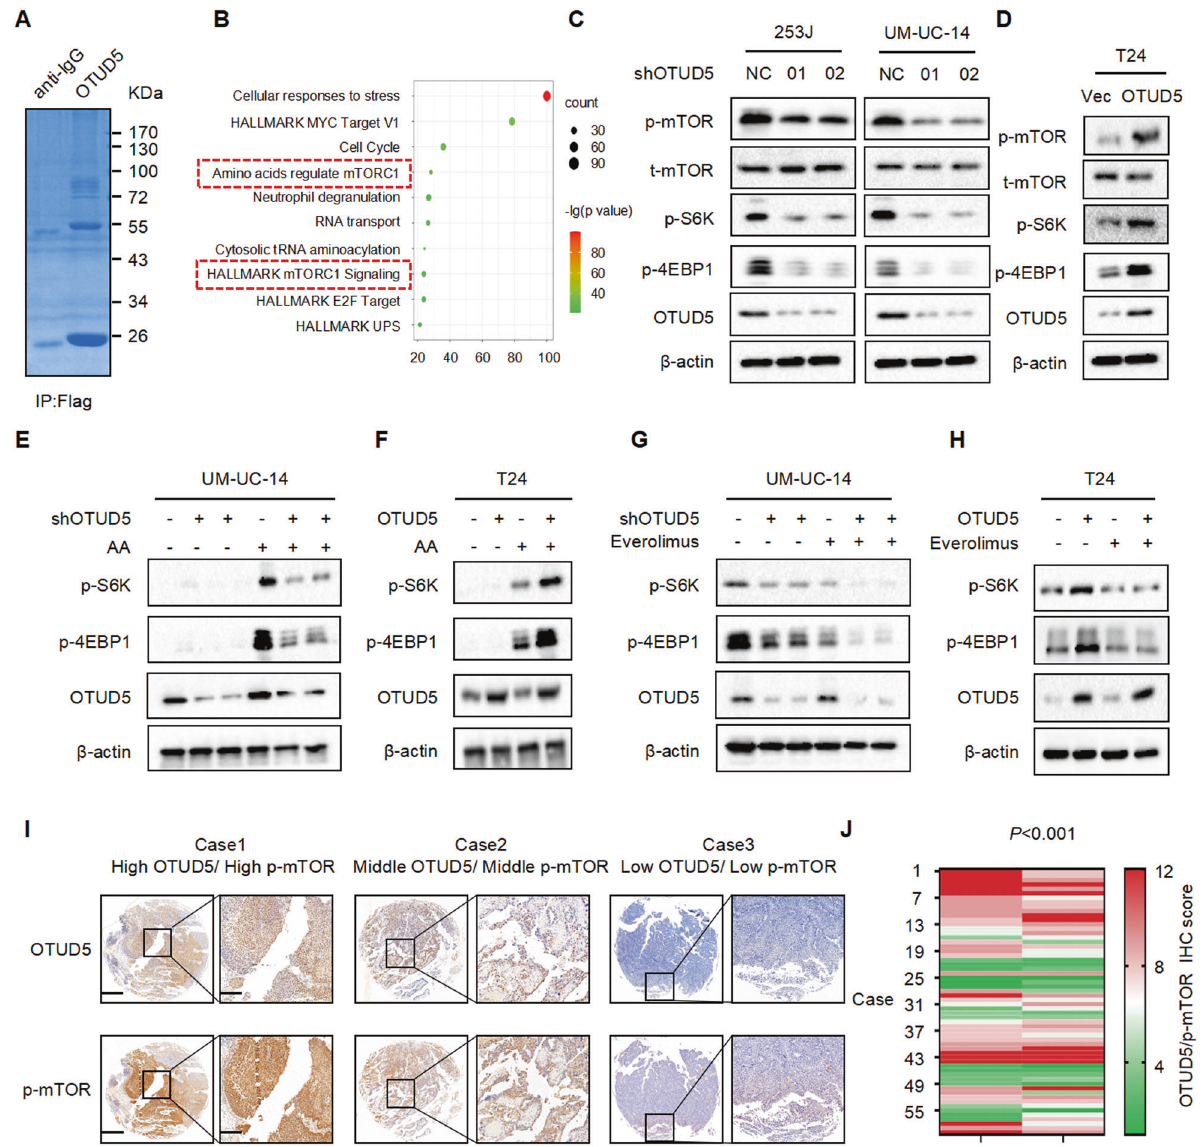
spectrometry results showed that OTUD5 is involved in the mTOR signaling pathway. C IB analysis of whole-cell lysates (WCL) derived from 253 J and UM-UC-14 cells stably expressing shOTUD5 and shNC. shNC was used as the negative control. p-mTOR, t-mTOR, p-S6K, p-4EBP1 and OTUD5 were detected. β -actin was used as the loading control. D IB analysis of WCL derived from T24 cells stably overexpressing OTUD5 and vector. Vector was used as the negative control. E , F UM-UC-14 shNC/shOTUD5 cells ( E ) and T24 Vec/oeOTUD5 cells ( F ) were subjected to amino acid starvation for 6 hours and resupplementation for 1 hour. p-S6K, p-4EBP1 and OTUD5 were detected. G , H UM-UC-14 shNC/ shOTUD5 cells ( G ) and T24 Vec/oeOTUD5 cells ( H ) were treated with or without everolimus. I Representative images of OTUD5 and